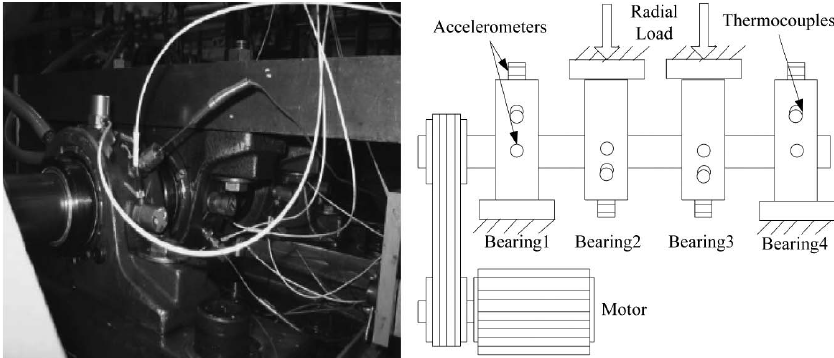
Figure 5. The experimental test rig and sensor placement illustration of IMS [28]. Fig. 2. Test rig.